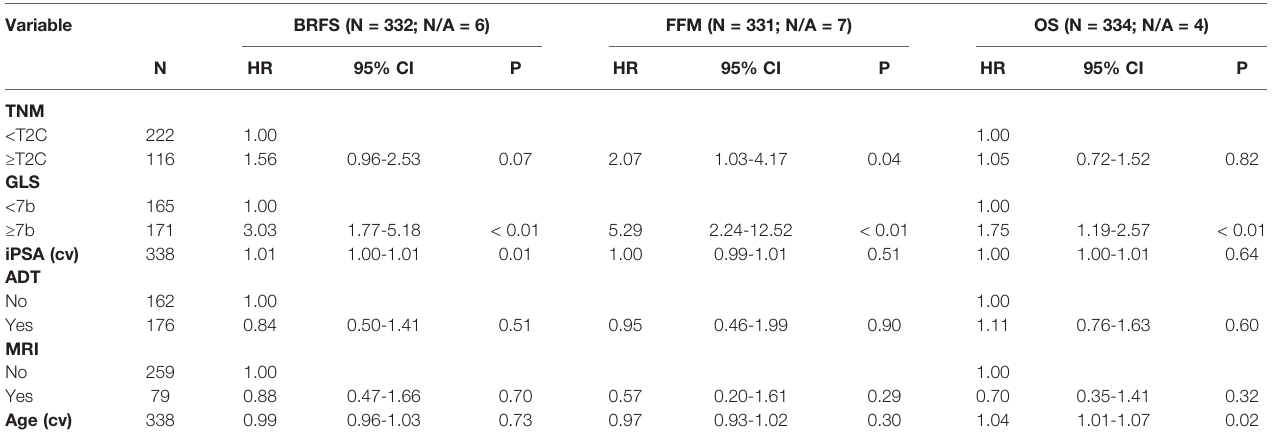
TABLE 2 | Cox regression